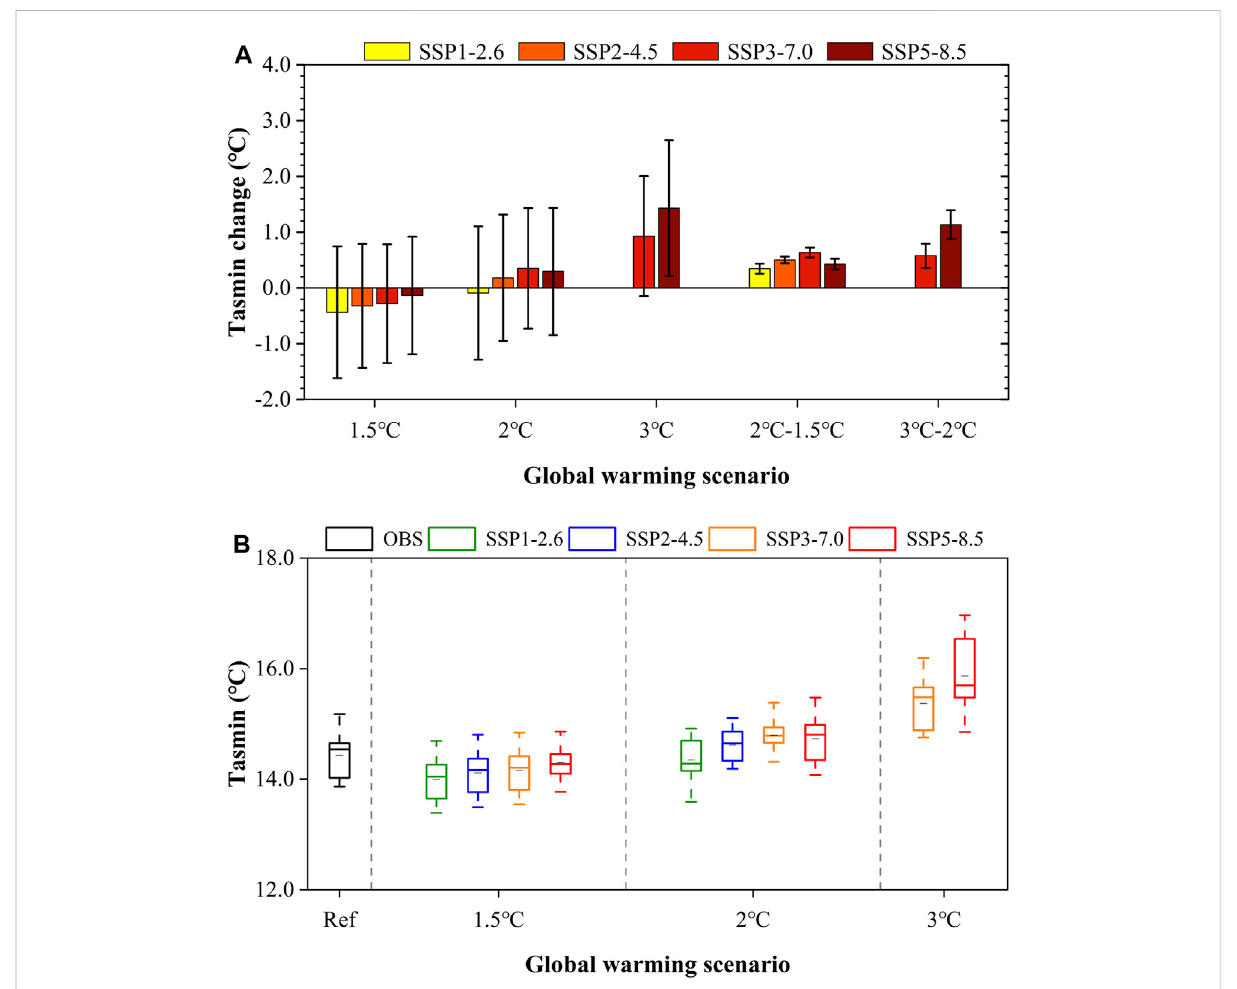
FIGURE 11 Boxplot diagram of Tasmin change under different scenarios (A) and the error bar plot of Tasmin change relative to the reference period (B) in the